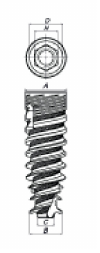
Figure 1. Illustration of MultiNeO TM